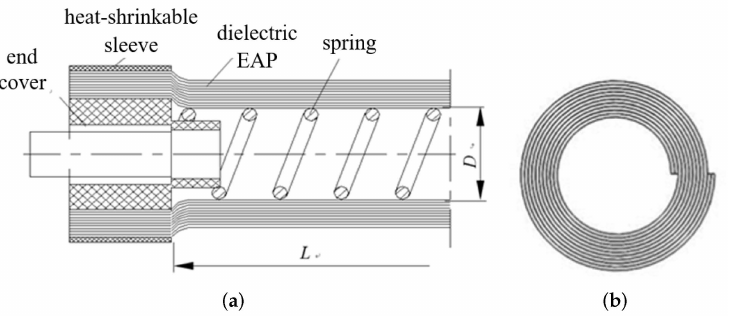
Figure 2. Schematic diagram of the structure of the cylindrical drive unit, where ( a ) is longitudinal section of driver unit and ( b ) is cross-section.